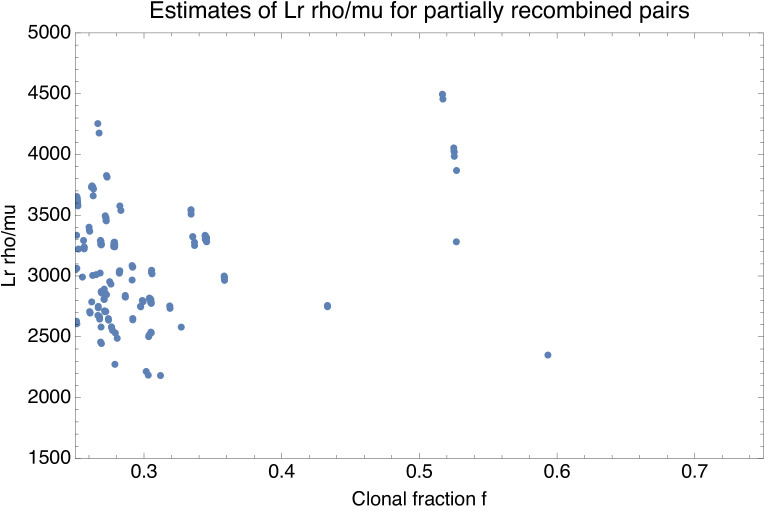
Estimate of the effective recombination strength Lr⁢ρ/μ (vertical axis) as a function of the estimated fraction of clonally inherited genome fc (horizontal axis) for each pair of strains with fc between 1/4 and 3/4.Each point corresponds to a pair of strains.